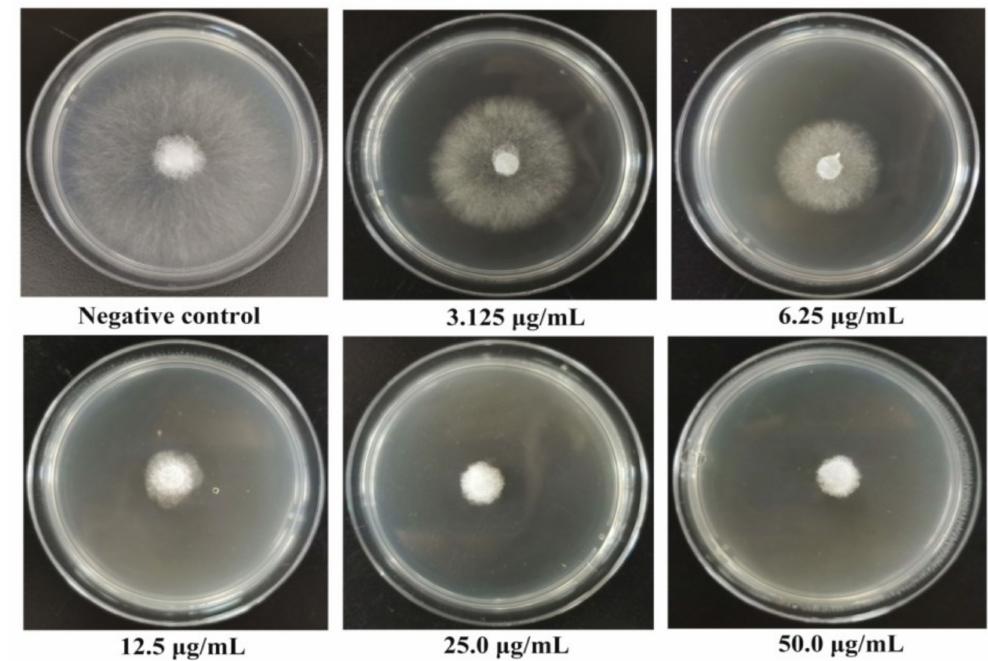
Figure 3. Inhibitory activity of compound F15 on mycelial growth of S . sclerotiorum